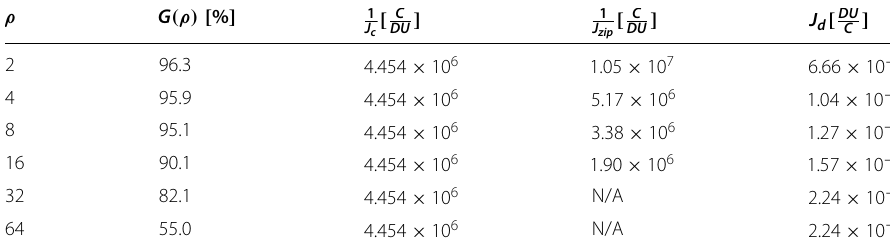
Table 3 LUT parameters for the